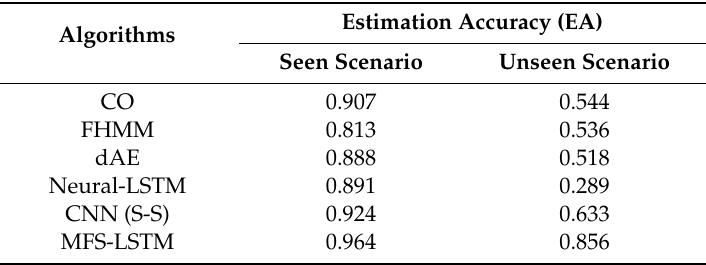
Table 9. Evaluation of total energy contributions by target appliances in disaggregation